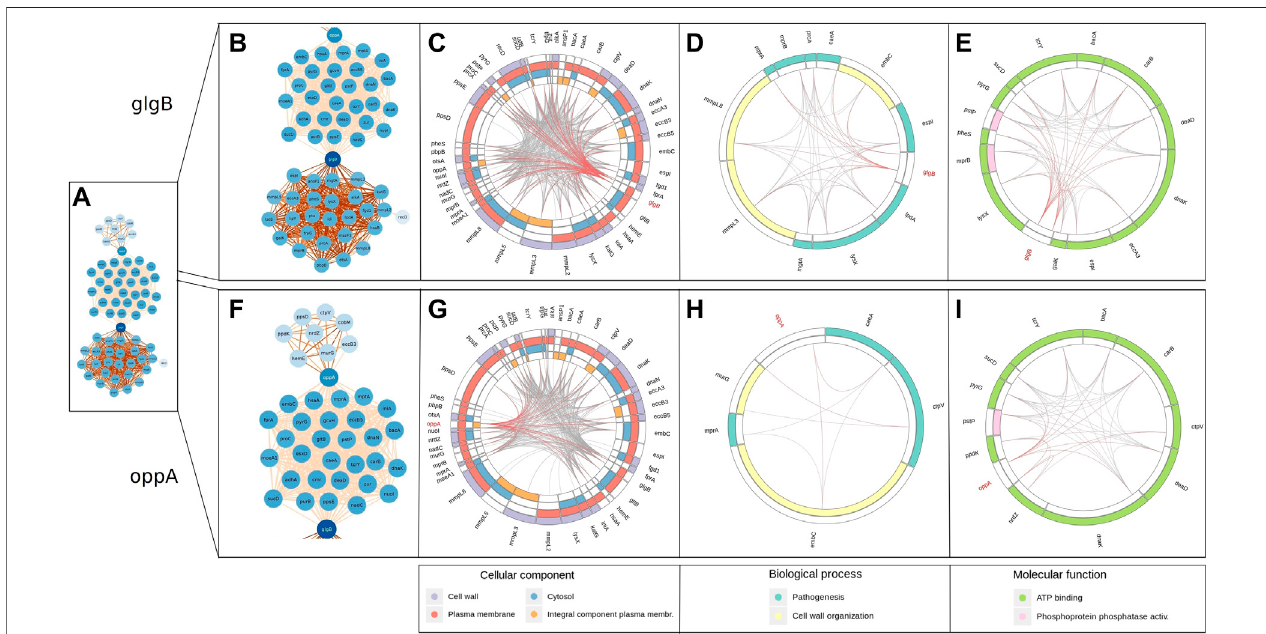
FIGURE 5 | Enriched GO terms of genes that interact with glgB and oppA . The arrangement and size of genes and positions of interactions re fl ect the pan – genome-wide alignment. Red lines indicate interactions of glgB and oppA , whereas gray indicates the interaction of other genes. (A) Epistatic network. (B) glgB interactions (subnet). (C) Enriched cellular components of genes interacting with glgB . (D) Enriched biological processes of genes interacting with glgB . (E) Enriched molecular functions of genes interacting with glgB . (F) oppA interactions (subnet). (G) Enriched cellular components of genes interacting with oppA . (H) Enriched biological processes of genes interacting with oppA . (I) Enriched molecular functions of genes interacting with oppA